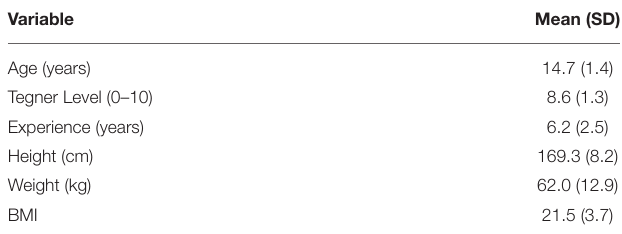
TABLE 2 | Athlete